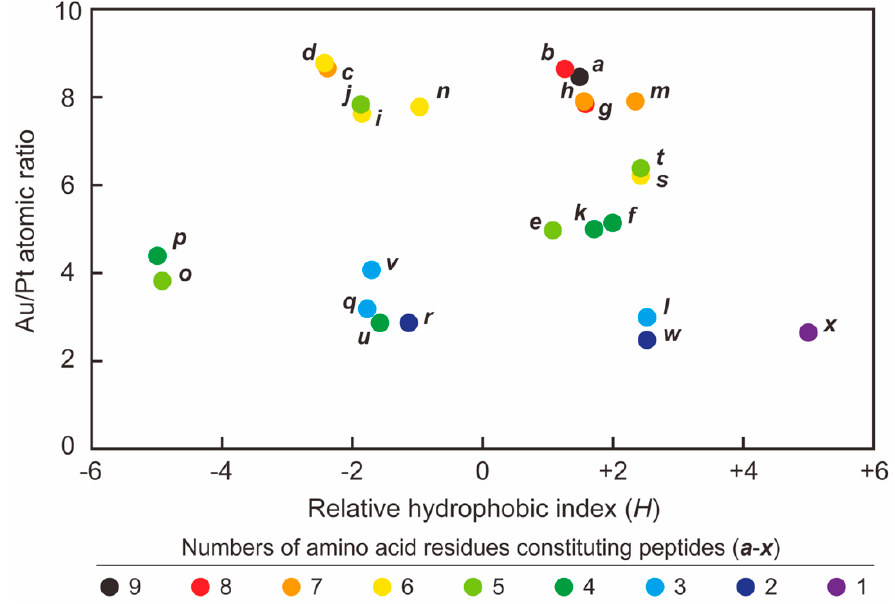
Figure 3. Relationships between the relative hydrophobic indices ( H ) for peptides a – x , the Au/Pt atomic ratios for the precipitates obtained with those peptides, and the number of amino acids constituting the peptides. These data are taken from Figure 2.